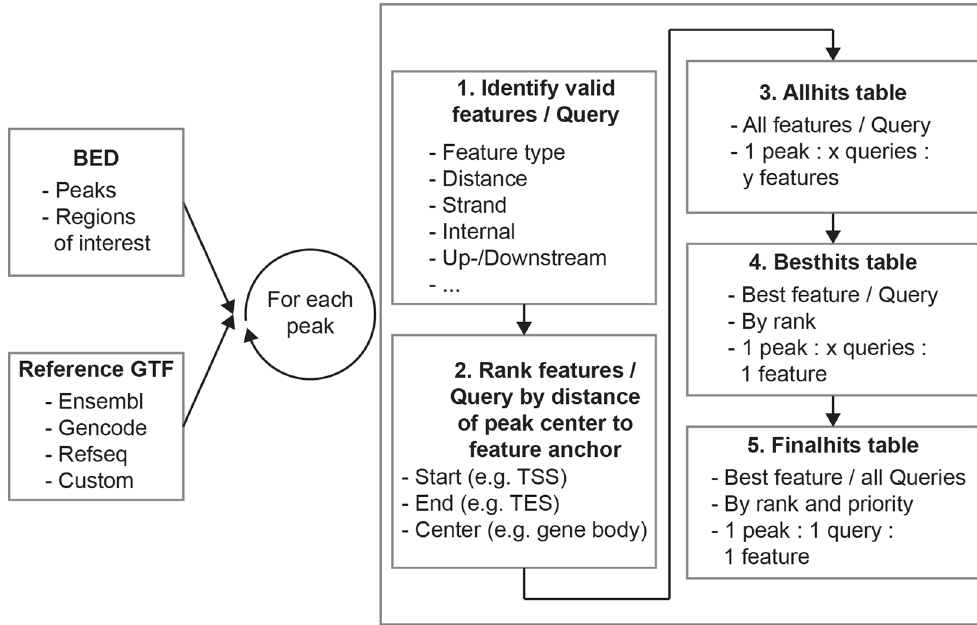
Figure 2. Outline of the UROPA algorithm. (1) For each peak all queries are consecutively checked for features satisfying various optional criteria. (2) The resulting candidate features are ranked for each query based on the distance of the peak center to the feature anchor(s) of interest (e.g. start, end, center of the feature). (3) All candidate features resulting from any query are stored in the”all hits” table. (4) The best candidate feature for each query is stored in the “best hits” table. (5) Only the one best feature among all queries is stored in the “final hits” table. This step can optionally include prioritization of queries to ensure a desired precedence (e.g. prefer protein_coding genes even if they are located farther away from the peak). These three output files cover various granularities considering the desired